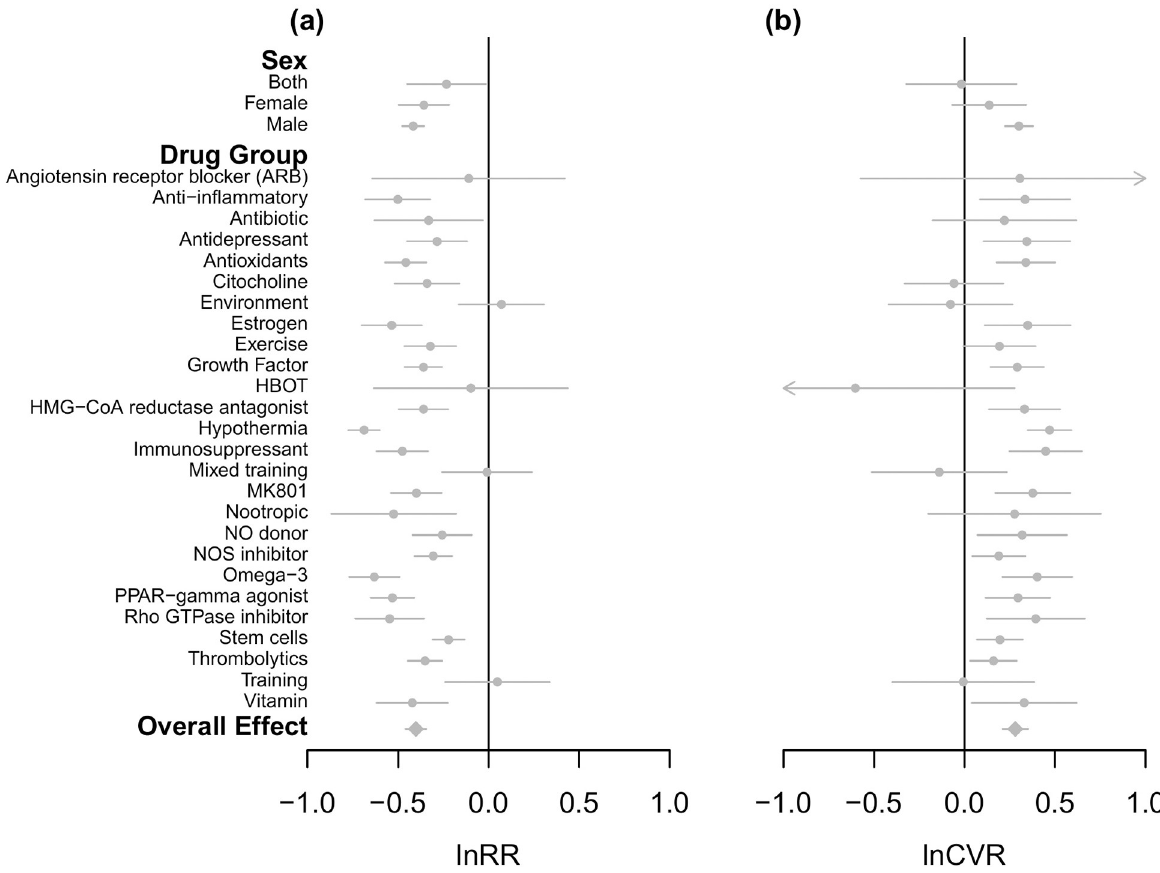
Fig 2. The effects of drug treatments on the difference in (a) mean (lnRR); and (b) variability (lnCVR) in infarct volume across control and experimental rat groups. Mean estimates of unconditional (marginalized), group-specific effects are shown as gray circles, while the overall estimate is indicated by the gray diamonds. Moreover, 95% CIs are shown as gray lines. Negative lnRR estimates indicate that mean infarct volume is smaller in experimental versus control rats. Negative lnCVR estimates show that interindividual variability in infarct volume is smaller in experimental versus control rats (e.g., HBOT indicated by left-pointing arrowhead), while positive lnCVR estimates show that variability in infarct volume is greater in experimental versus control rats (e.g., ARBs indicated by right-pointing arrowhead). The overall and group-specific estimates were obtained from MLMA and MLMR models, respectively. The data underlying this figure can be found at https://doi.org/10.6084/m9.figshare. 14527317.v4. ARB, angiotensin receptor blocker; CI, credible interval; HBOT, hyperbaric oxygen therapy; HMG-CoA, β -Hydroxy β - methylglutaryl-CoA; lnCVR, log coefficient of variation ratio; lnRR, log response ratio; MLMA, multilevel meta-analysis; MLMR, multilevel meta- regression; NO, nitric oxide; NOS, nitric oxide synthase; PPAR, peroxisome proliferator–activated receptor.